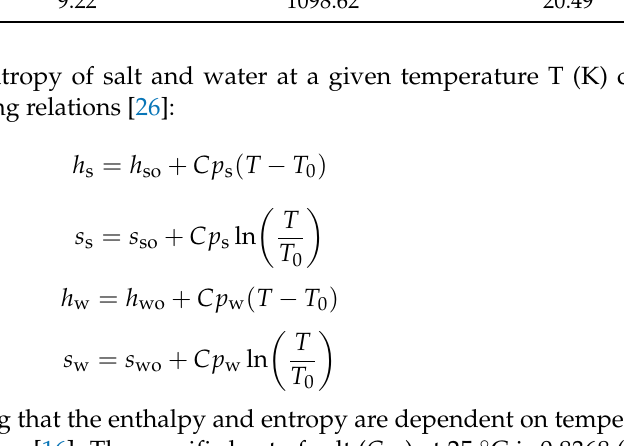
Table 2. The dead state operating conditions of the RO desalination plant of the APC. Temperature ( ◦ C) Pressure (atm) Salinity (ppm) Flow Rate (kg/s) 25 9.22 1098.62